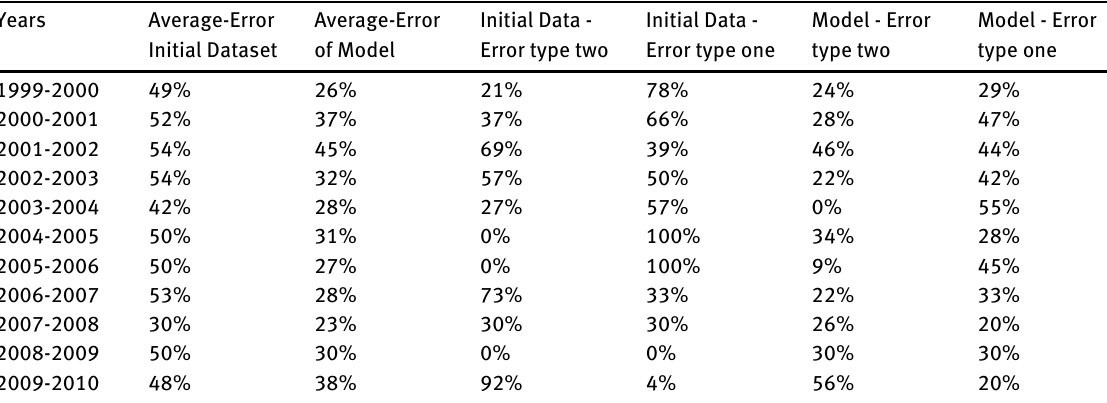
Table 4: Forecast with 63% tree growing sample, 33% stressed inputs and 1 year feedback, out-of-sample event calibration. The measures are shown in % of the underlying dataset.